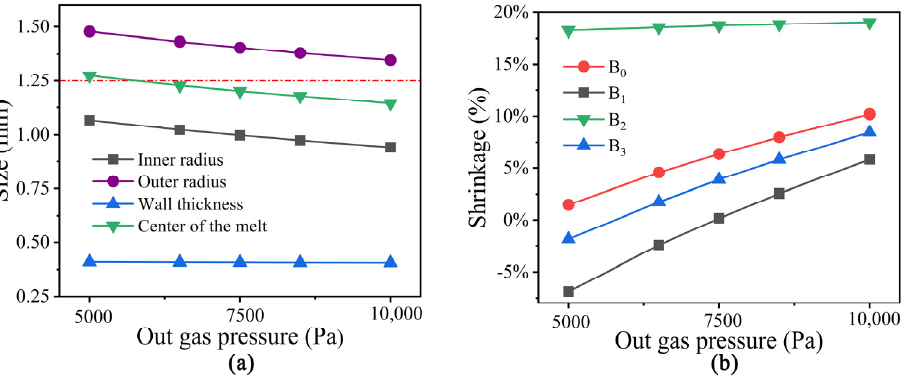
Figure 3. Dimensions and shrinkage rates of the micro-tube under different pressure of the outer gas cushion layer. ( a ) Dimensions of the micro-tube; ( b ) Shrinkage rate of the micro-tube.